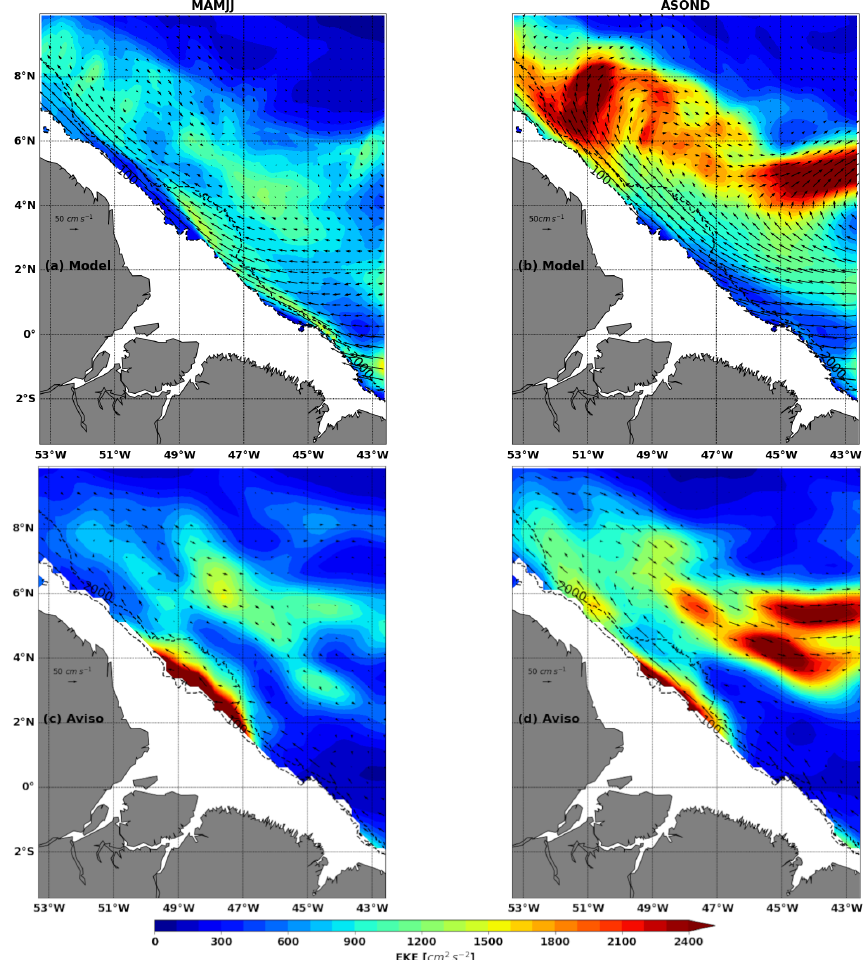
Figure 3. (a, b) Model mean surface EKE (colours, units: cm 2 s − 2 ) and current (arrows, units: cms − 1 ) during (a) MAMJJ and (b) ASOND. (c, d) AVISO mean surface EKE during (c) MAMJJ and (d) ASOND. Dashed black contours are 100 and 2000m isobaths. Bathymetry less than 100m is